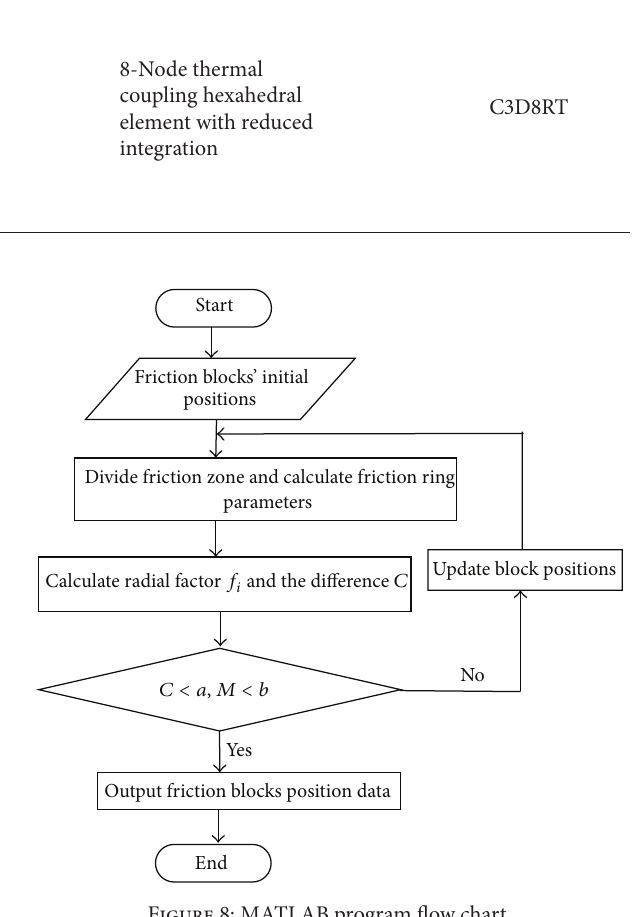
Figure 8: MATLAB program flow chart.